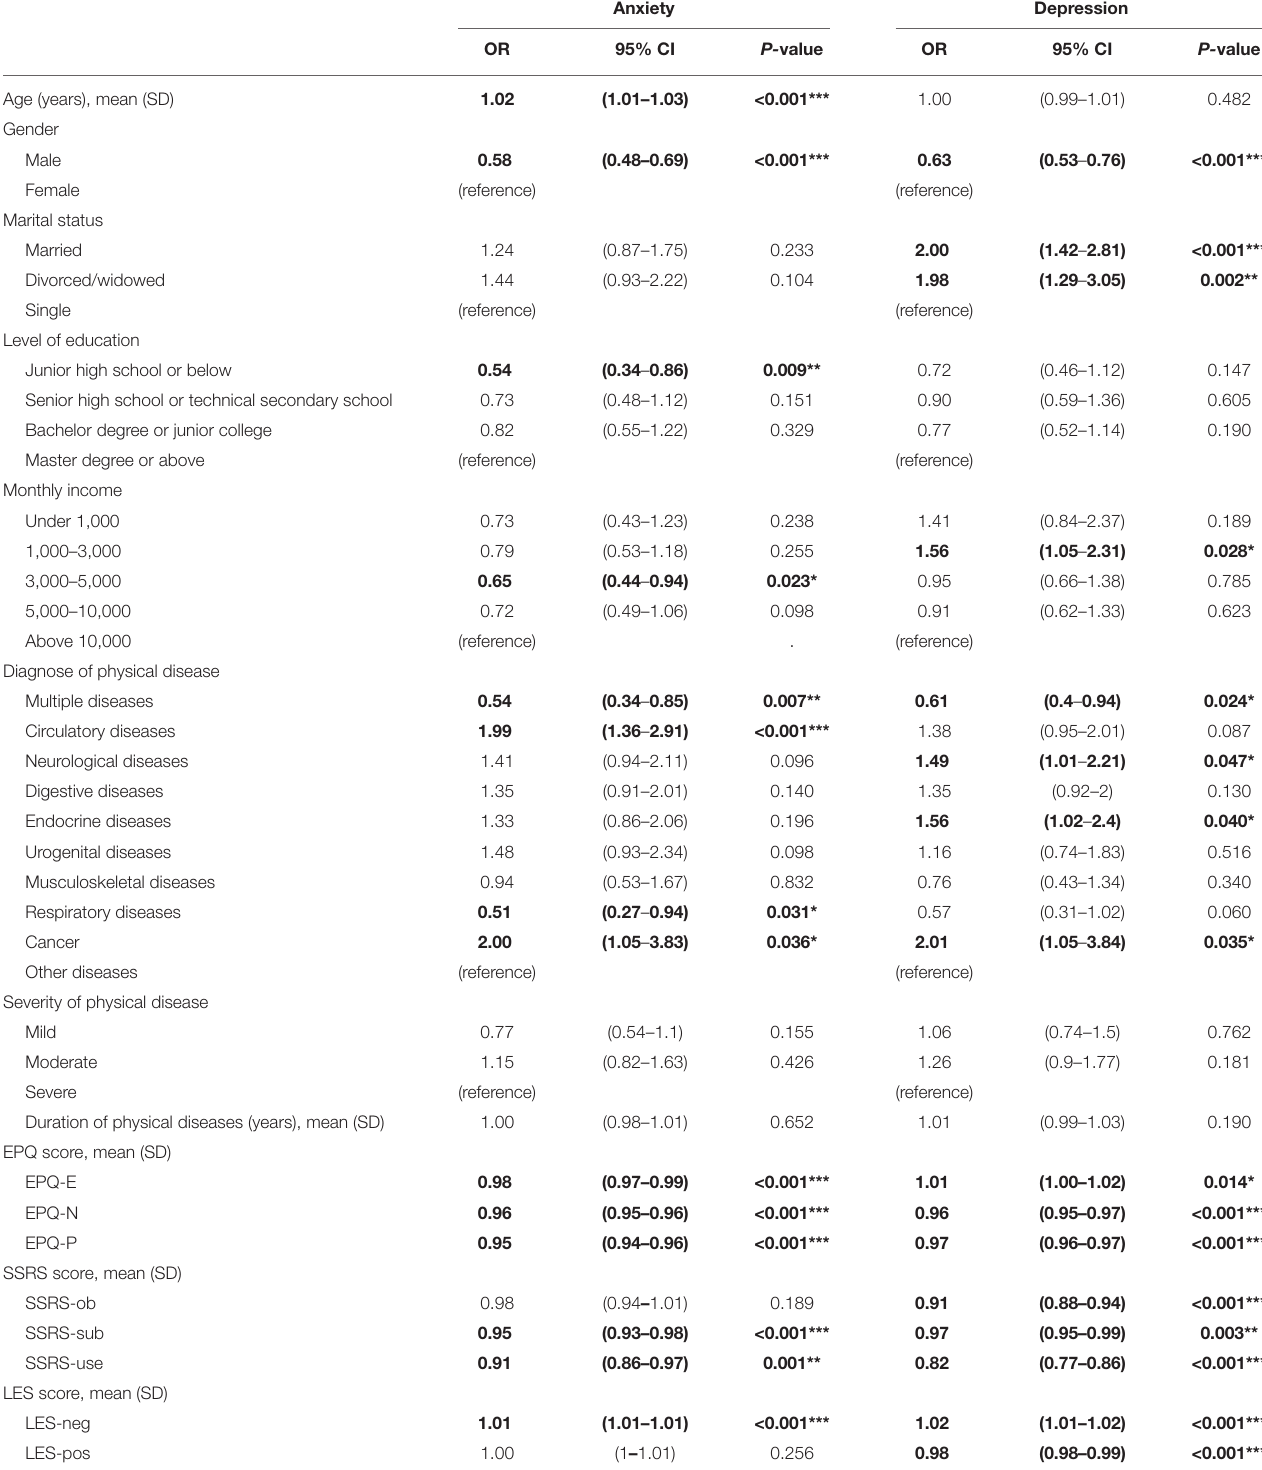
TABLE 5 | Factors associated with anxiety and depression by multivariate ordered logistic regression.